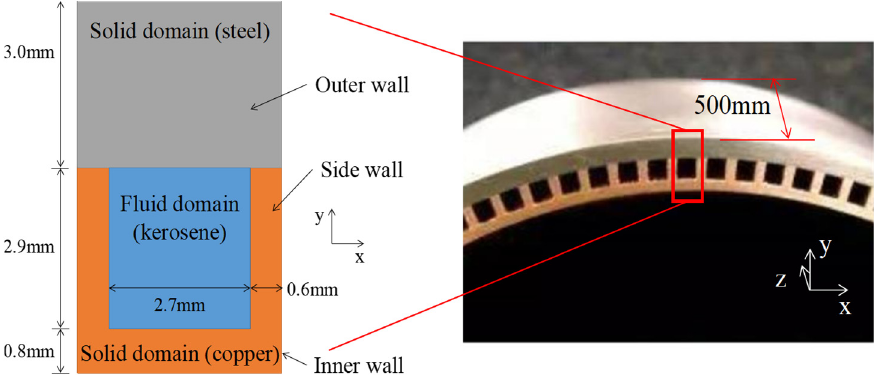
Figure 1. Schematic diagram of the cooling channel and the physical picture.